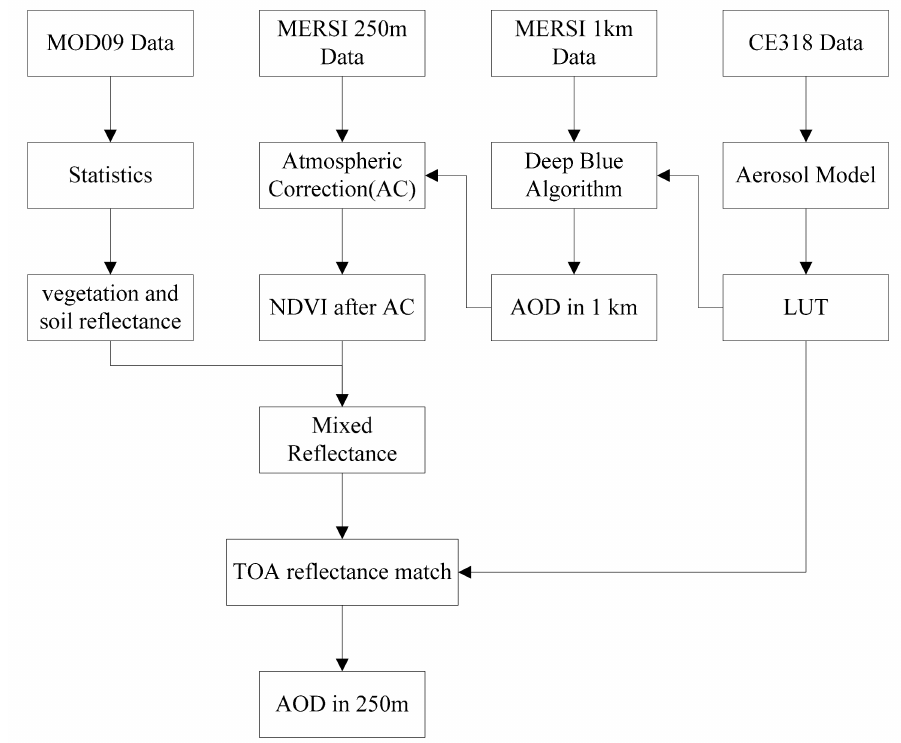
Figure 2. Flowchart of aerosol optical depth (AOD) retrieval from MERSI 250-m data.